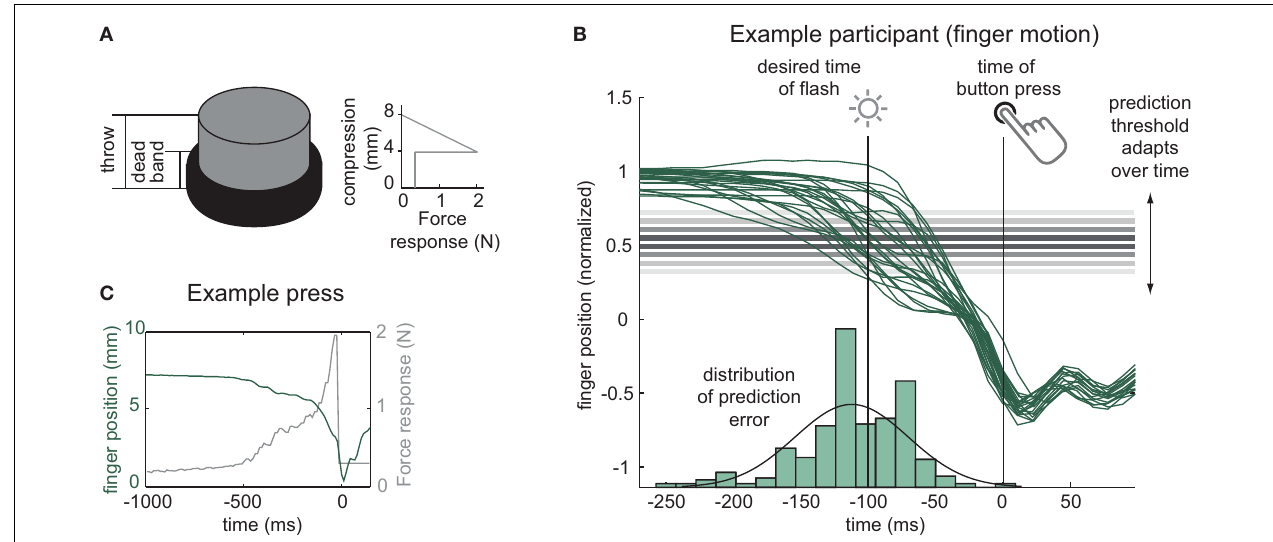
bottom) for a l= − 100ms (vision-lead) stimulus in an example participant.The adaptive threshold moves up and down according to the sign of the error on a previous trial. (C) Example button press (green) and force-response (grey) across